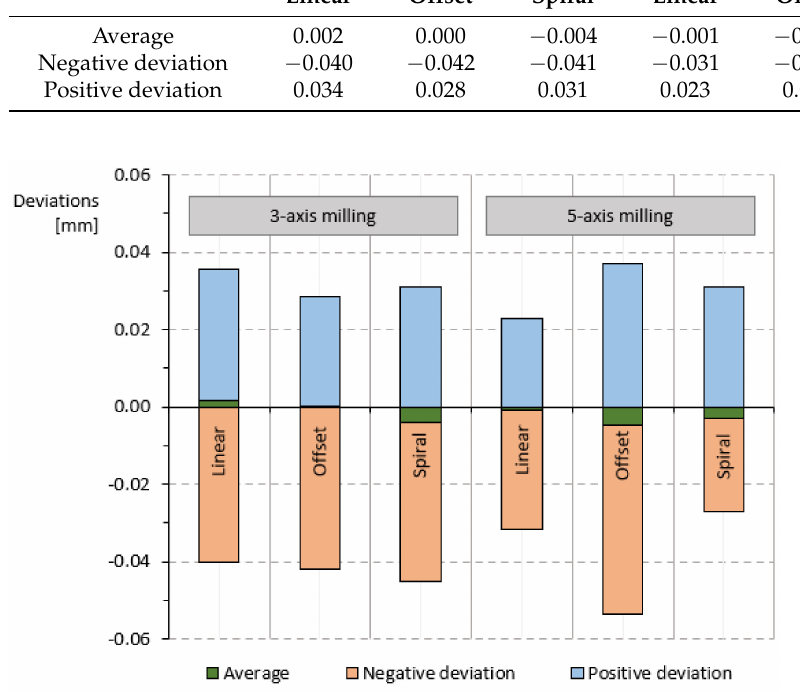
Figure 6. Graph of the average deviation, maximum negative and positive deviation for each